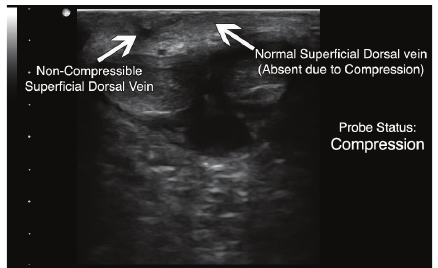
Figure 2: Compressed view of superficial dorsal veins showing non- compressible right superficial dorsal vein (depth set at 4cm).